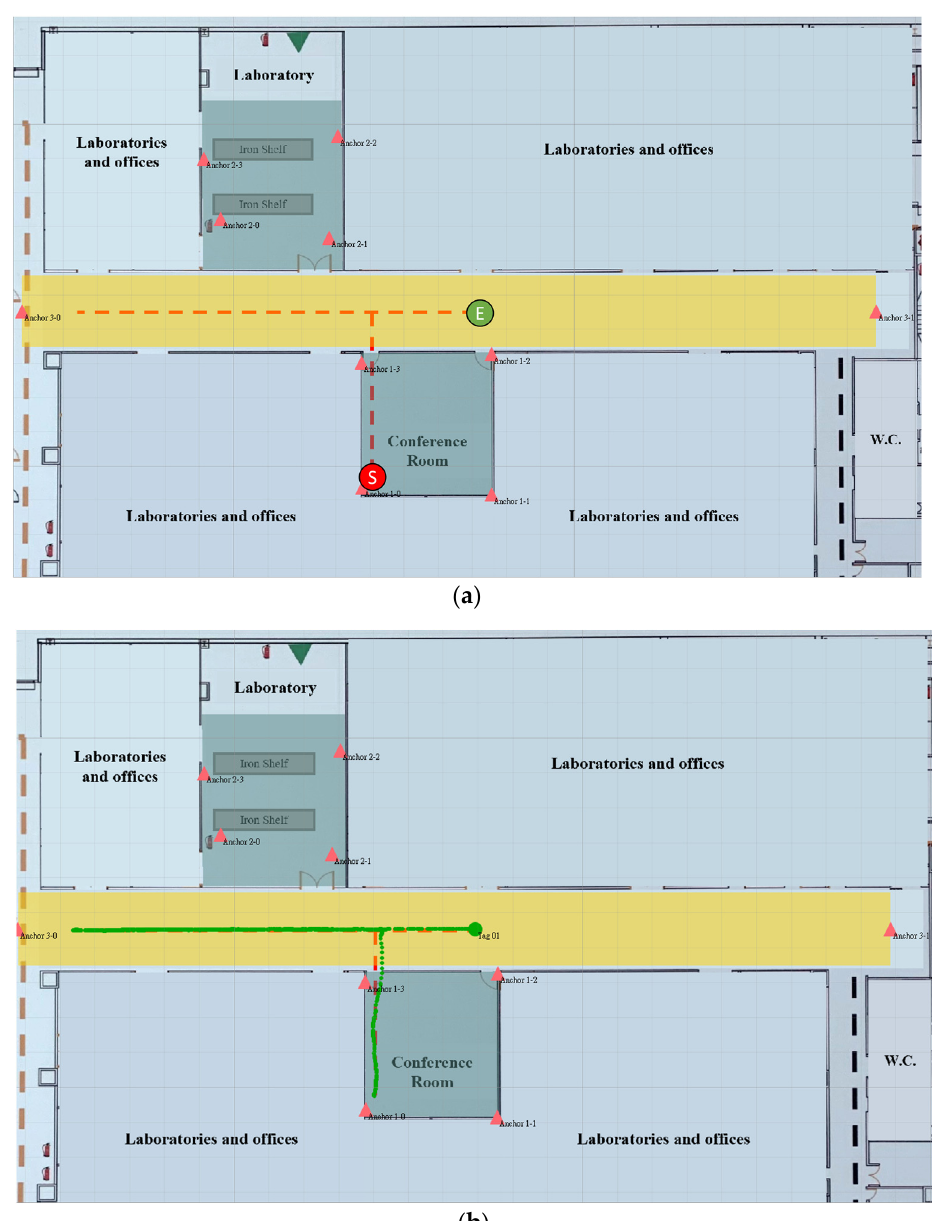
Figure 23. ( a ) Real trace and ( b ) estimated trace of tag 1.